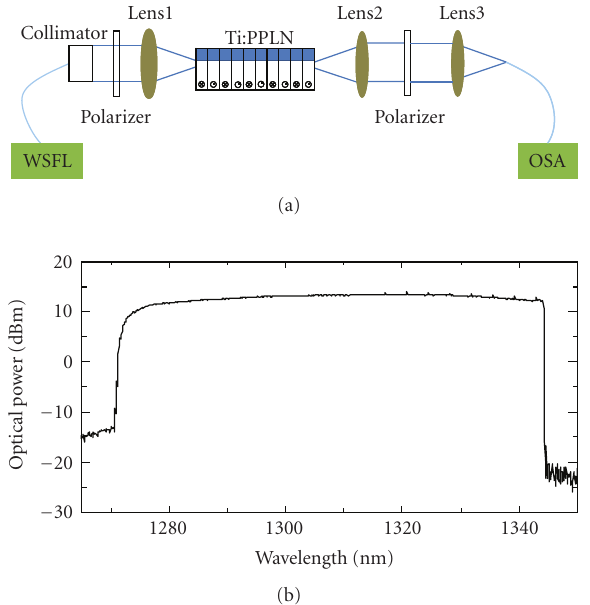
Figure 5: (a) Schematic diagram of measurement setup for Ti:PPLN ˇSolc-type wavelength filter and (b) spectrum of wave- length swept fiber laser (WSFL).